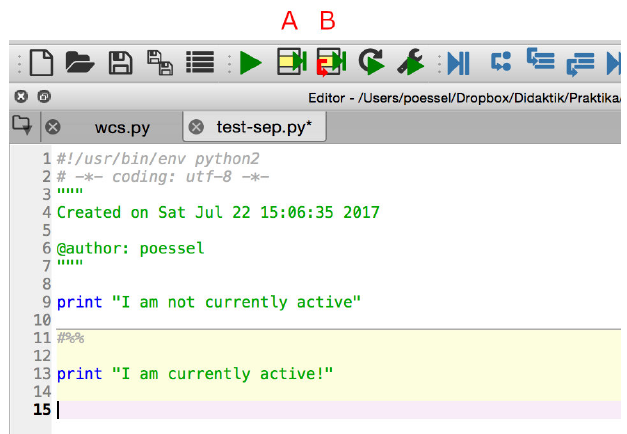
Fig. 81.— Using hashtag-percent-percent for zoning in Spyder. The two specific play symbols have been labelled in red as A and B, by me this case, the lower region, from the #\%\% to the end of the file, is marked in yellow (except for the line the cursor is in, which is marked in pink). Note that, to the right of the green play symbol, there are two others that show a region marked in yellow; I have labelled those A and B in Fig. 81. If you click on the icon labelled A, Spyder will execute only the part marked in yellow. If you click on the icon labelled B, Spyder will also execute the part marked in yellow, and then move on to the next region, marking that one yellow. This is highly useful for debugging. If you are not sure what is going wrong with your code, try to separate your code into regions by using the #\%\% . Then execute those regions one by one, seeking to understand what is happening in